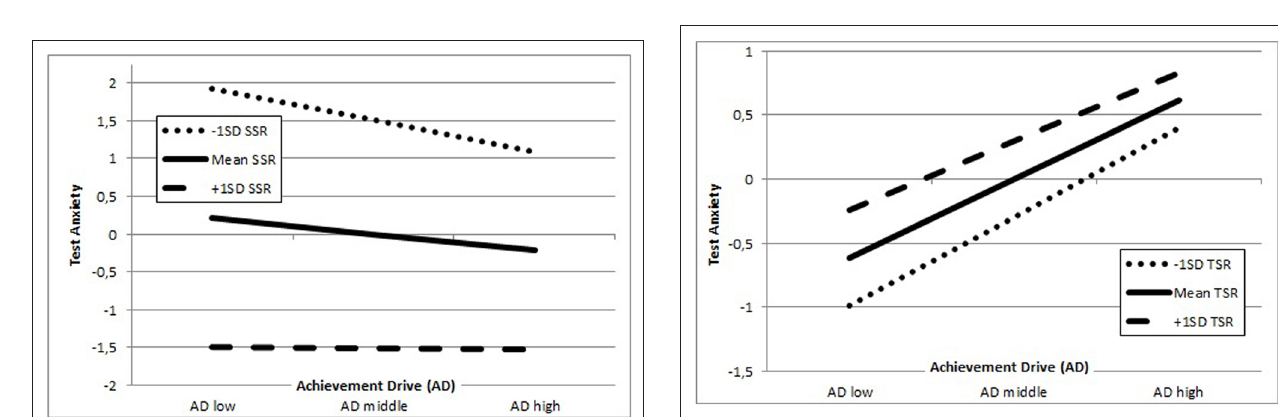
perceive their relationship with other students to be, the less they report feelings of TX.